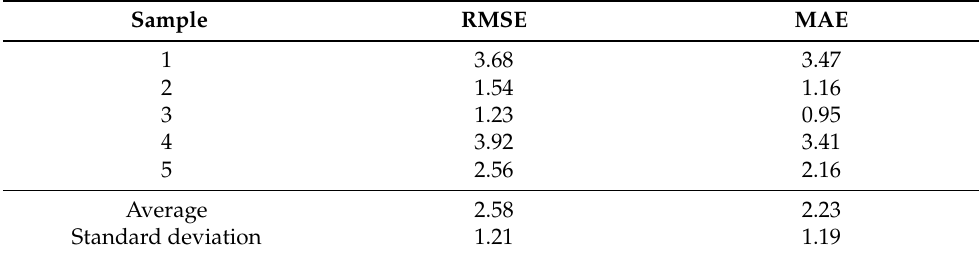
Table 6. Best results using AutoSklearn with MR.